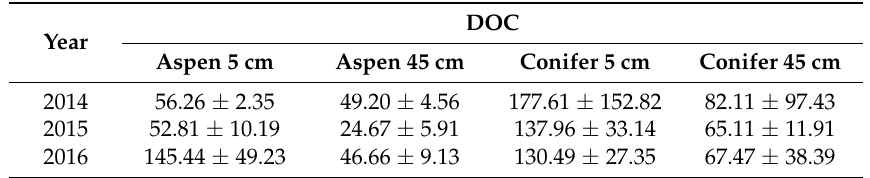
Table 2. Dissolved organic carbon (DOC) (kg · ha − 1 ) transport during snowmelt period ± standard deviation ( n = 3 plots per overstory type at